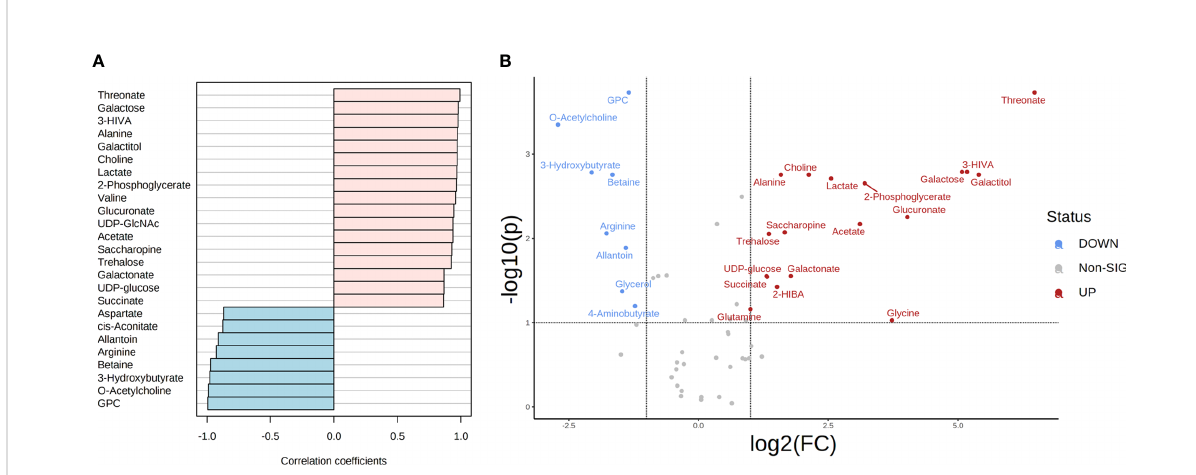
FIGURE 5 Metabolite correlation and signi fi cant differences in the metabolome of T. reesei and A. niger grown on lactose for 48 h. (A) List of the top 25 metabolites with higher correlation patterns in T. reesei (pink) and A. niger (blue). All metabolite correlation coef fi cients shown were signi fi cant (Pearson correlation > 0.7 and FDR < 0.1). (B) Volcano plot of metabolites with signi fi cant difference between both fungi. Metabolite levels were increased (red) or reduced (blue) in T. reesei compared to A. niger . 3-HIVA, 3-hydroxyisovalerate; UDP-GlcNAc, UDP-GlcNAc - uridine